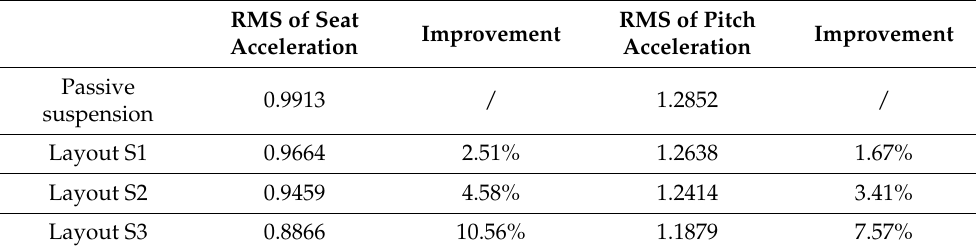
Table 3. Comparison of the different seat suspension